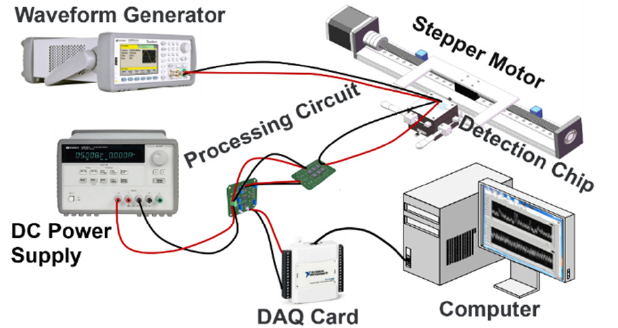
Figure 7. Experimental system diagram.